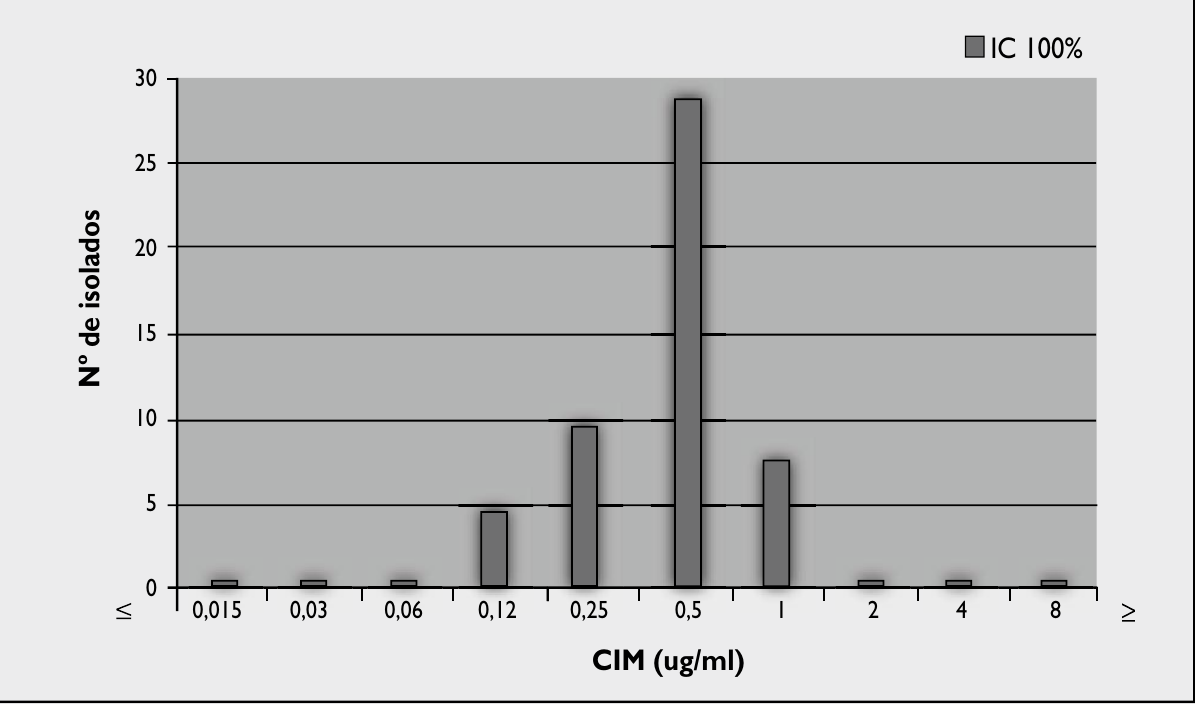
Figura 3 – Distribuição dos valores de CIM de anfotericina B, calculados para índice de inibição de 100%, em isolados de Candida albicans do fl uido vaginal de 51